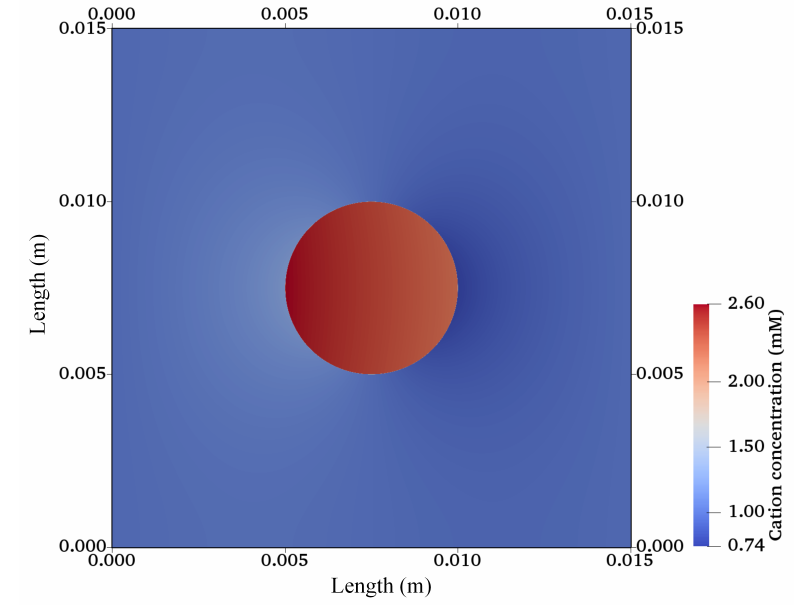
Figure 7. Cation-concentration profile for a hydrogel scaffold immersed in